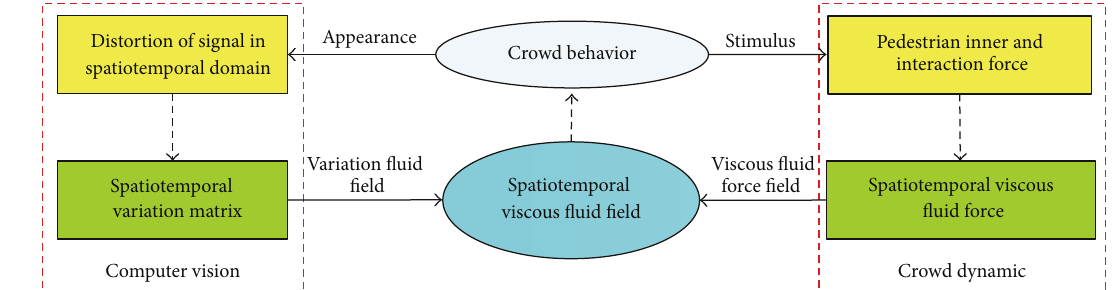
Figure 1: Examples of the large-scale crowd.